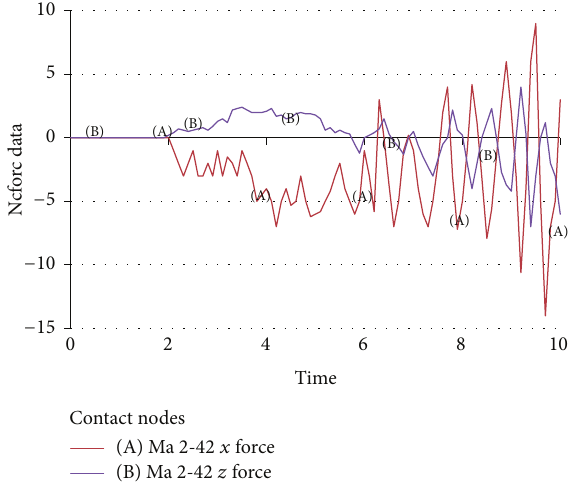
Figure 5: Distributions of the vertical and shearing force in block element Ω A ( 𝑧 -axis: vertical force, 𝑥 -axis: shearing force).